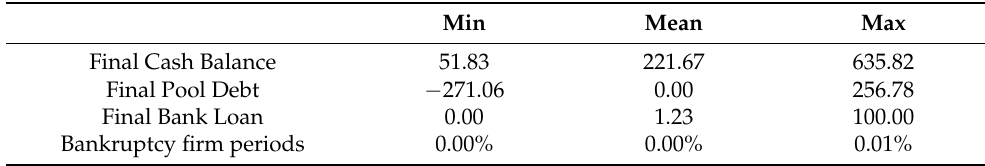
Table 7. Results for the base case with cooperation and interest rate difference (0.50%-0.50%-1.00%) (Correlation = 0.00).